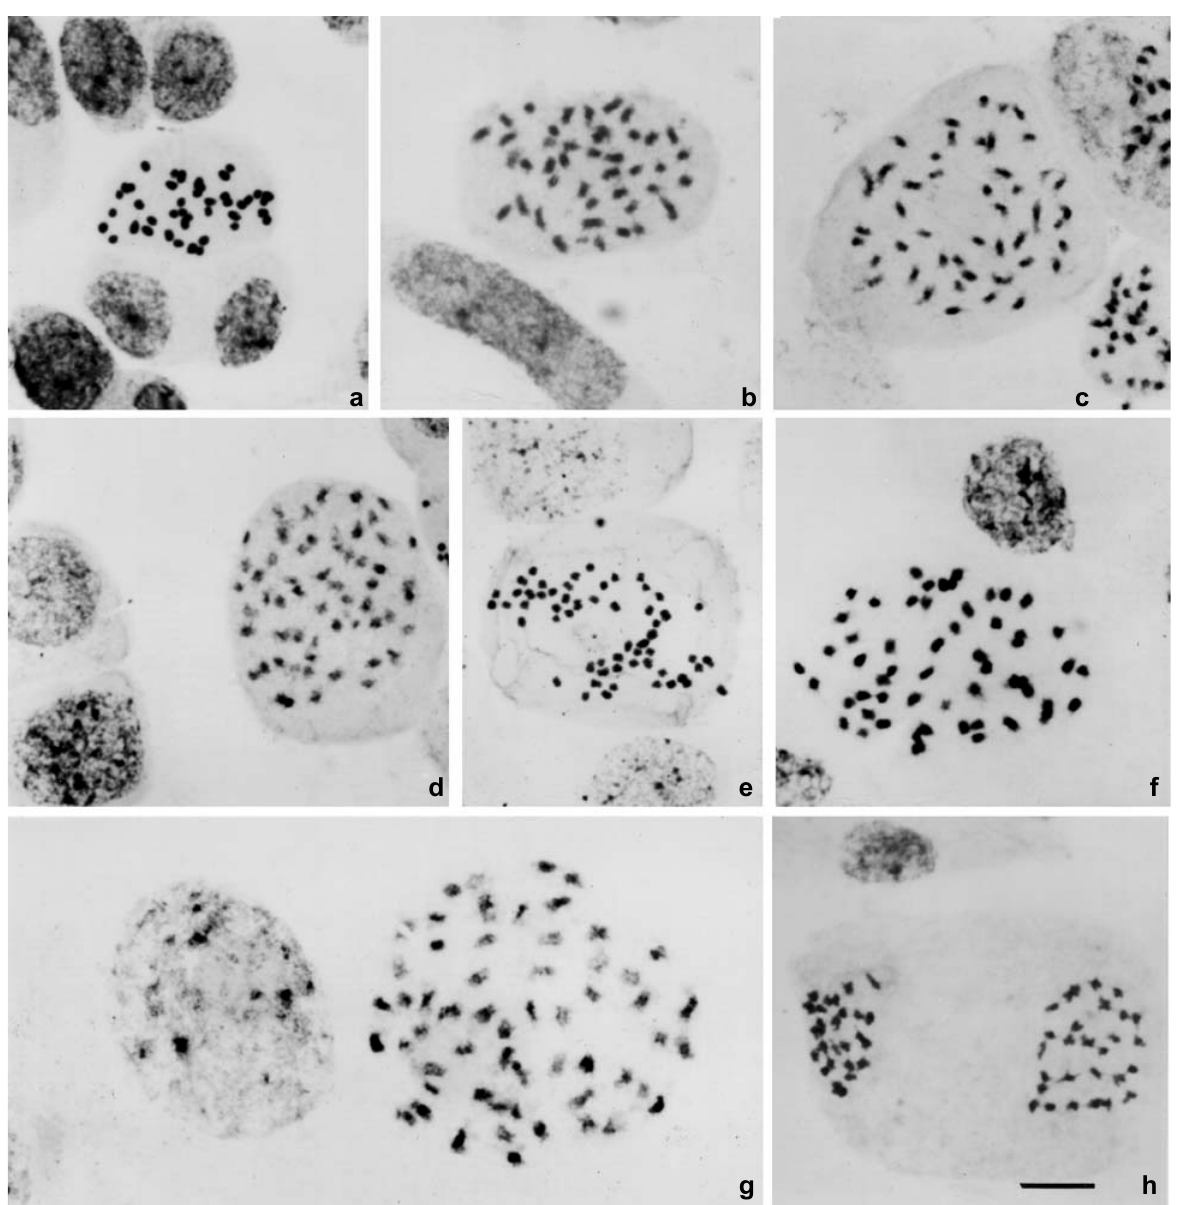
Figure 4 - Chromosome complements and interphase nuclei of orchid species of the subtribe Oncidiinae: ( a ) mitotic metaphase and interphase nucleus of Rodriguezia bahiensis (2n = 42); ( b ) R. lanceolata (2n = 42); ( c ) Notylia lyrata (2n = 44); ( d ) Lockartia goyazensis (2n = 56), and ( e ) Oncidium barbatum (2n = 56); ( f ) O. baueri (2n = 56); ( g ) O. aff. crispum (2n = 56), and ( h ) meiotic prophase II of O. flexuosum (n = 28). Bar represents 10 µ